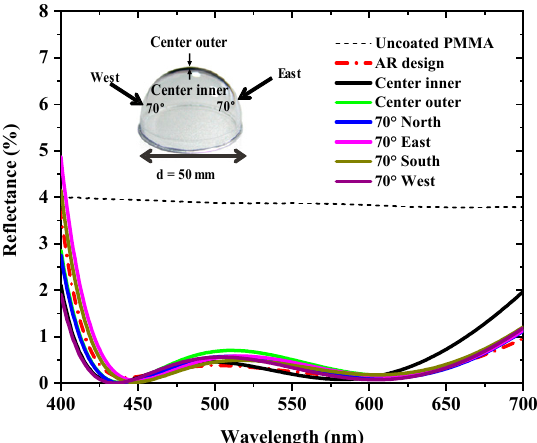
Figure 5. Measured reflectance spectra at the center positions of the outer and inner surfaces of the PMMA dome and at 70° inclined positions in four directions along the outer surface exhibit excellent 3D conformality of ALD coatings.